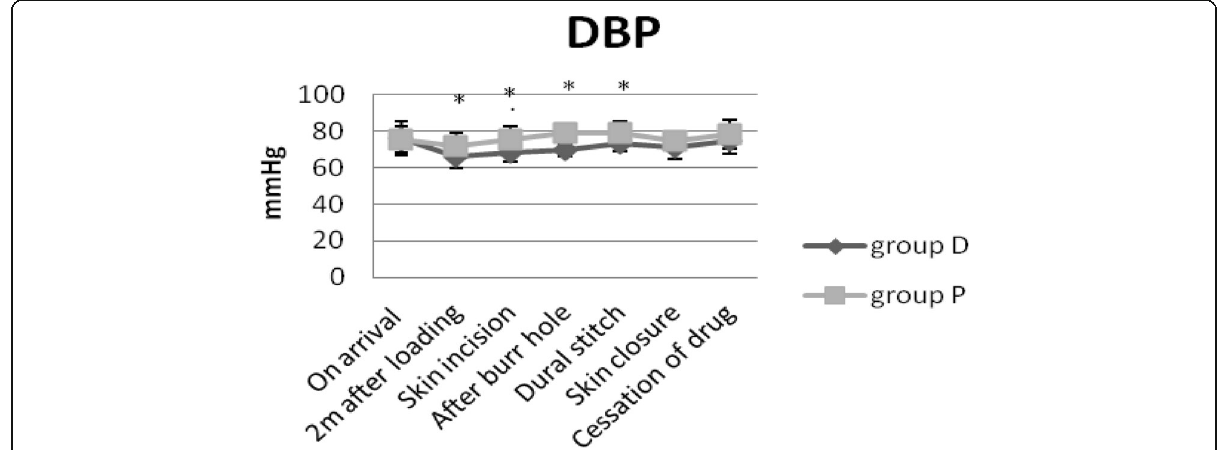
Fig. 3 Changes in DBP. Changes in mean values of DBP over time. Lines are mean DBP and error bars are SD. *Statistical significance between groups